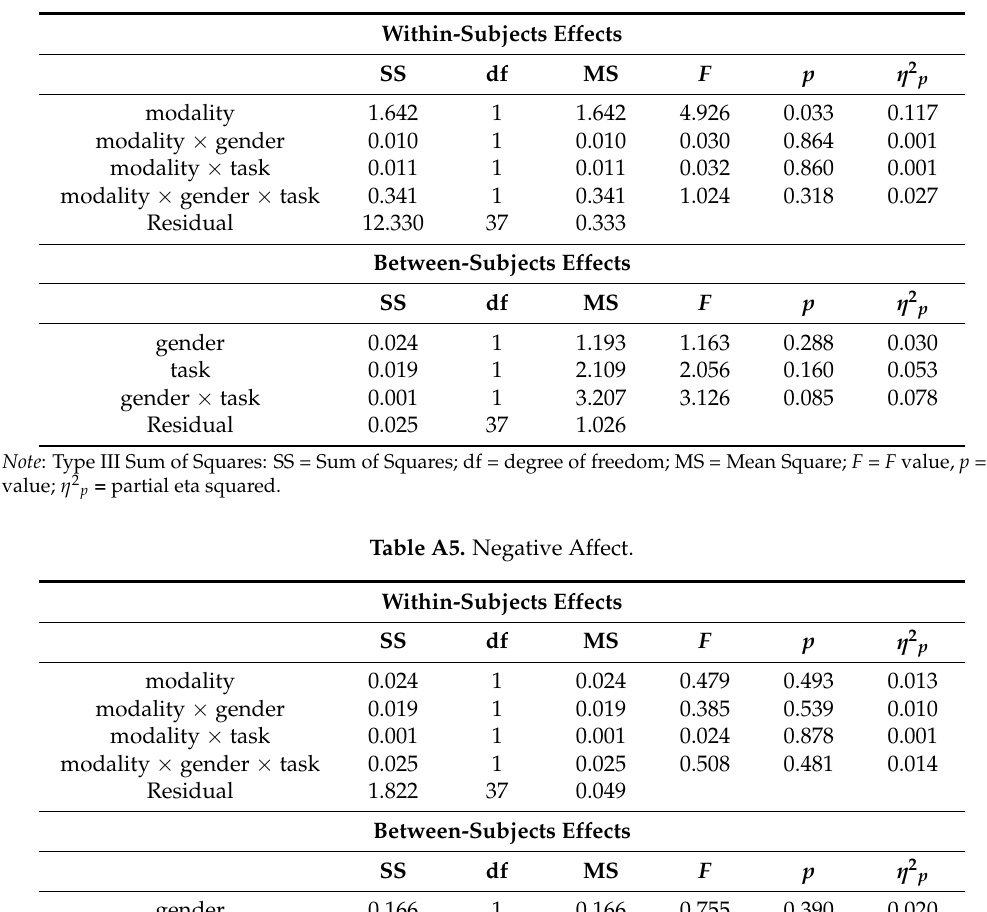
Table A4. Attentiveness.